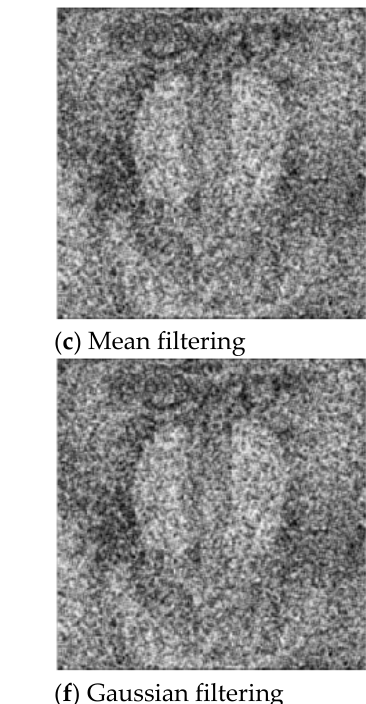
Figure 6. Baboon image enhancement for four classical filtering methods. Table 3. Baboon image under four classical filtering algorithms for PSNR (dB).